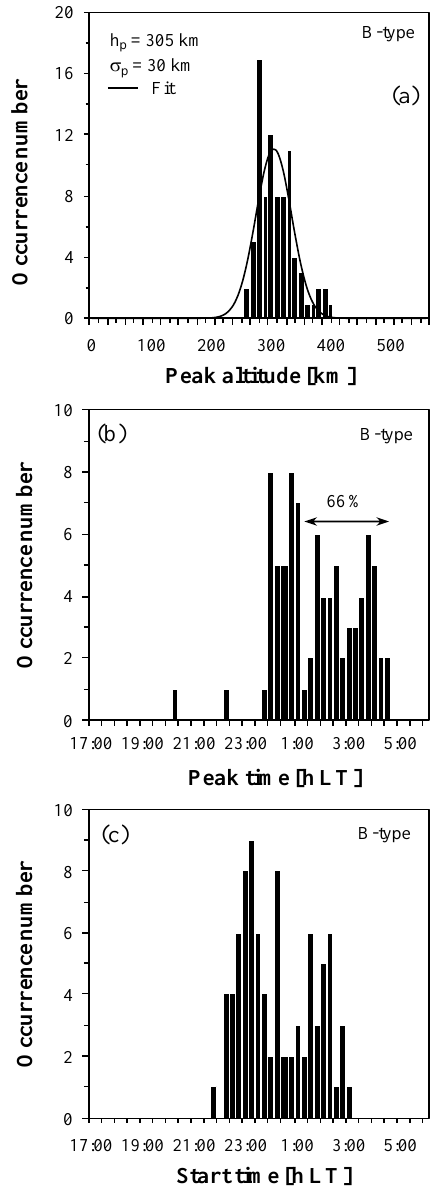
Figure 10. Same as Fig. 9 but for the equinox periods. Note that in (b) the instant at the maximum varies within the extended period from about 00:00LT to 05:00LT, indicating that, during the equinox periods, the uprising motion of phase III may reach its peak at any time in that period. Similarly, in (c) the instant at the start varies within the extended period from about 22:30 to